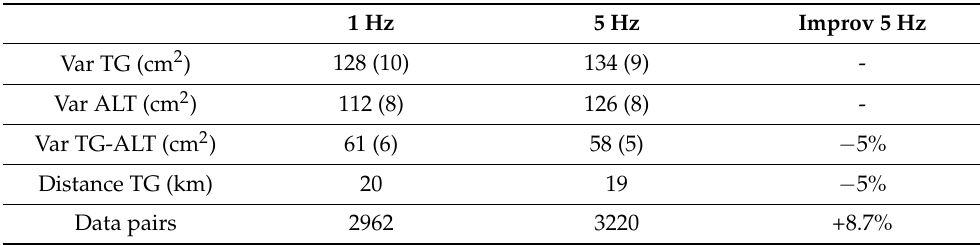
Table 6. Inter-comparison of S3A measurements and tide gauge data from the European coasts in terms of variance in the differences between both datasets. The mean distance between tide gauges and the most correlated along-track altimetry points, as well as the number of total data pairs (altimetry–tide gauge) used in the computation, are displayed. The common tide gauge stations for 1 Hz and 5 Hz products were used. () shows the uncertainties (error bars) computed for variance from the bootstrap method using 10.000 iterations. Finally, the improvements (%) for 5 Hz data compared with tide gauges in terms of lower variance in the differences (altimetry–tide gauge), lower mean distance between the most correlated altimetry point and tide gauges, and larger number of available data with respect to 1 Hz data are also